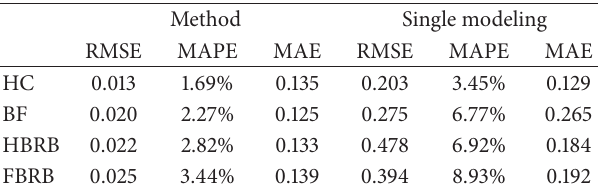
Table 4: Performance of the statistical error metrics applied to the combination of all model outputs. Also, the performance of the forecasting without the frequency decomposition is also shown in the